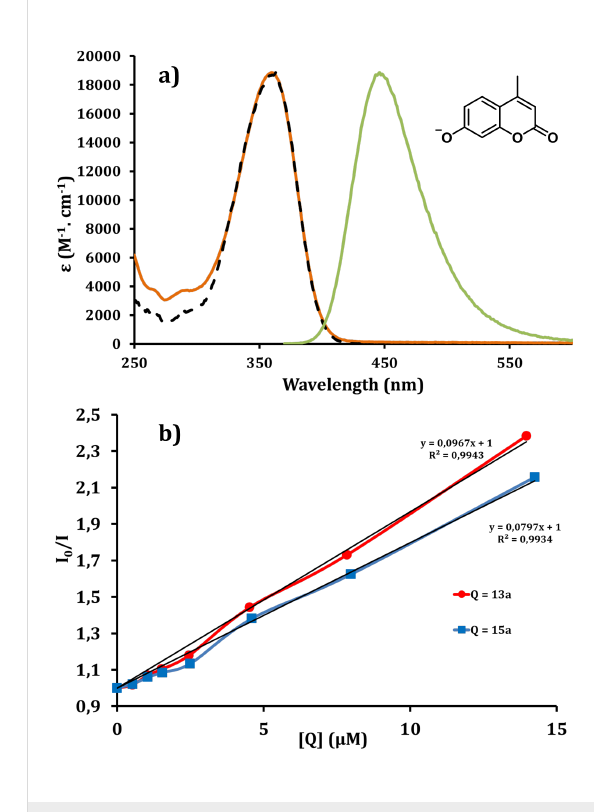
Figure 4: a) Absorption (orange line), corrected emission (green line) ( λ exc = 360 nm) and excitation (dashed black line) ( λ em = 445 nm) spectra for the anion of 4-methylumbelliferone; b) Stern–Volmer plots concerning the quenching of fluorescence of the anion of 4-methylum- belliferone by 13a (red line) and 15a (blue line) and their linear